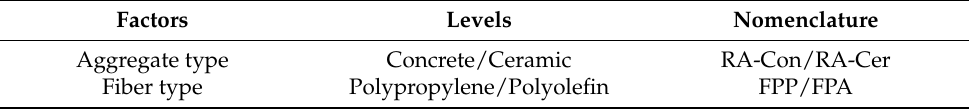
Table 8. Factors and levels used for the analysis of variance (ANOVA).